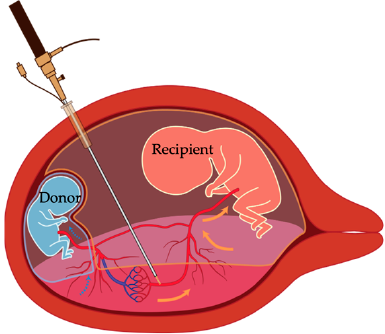
Figure 1. Pathology of TTTS. Circulatory imbalance is caused by a net transfusion of blood from donor to recipient in the presence of deep vascular anastomoses and develops chronically between hemodynamically connected monochorionic twin fetuses.